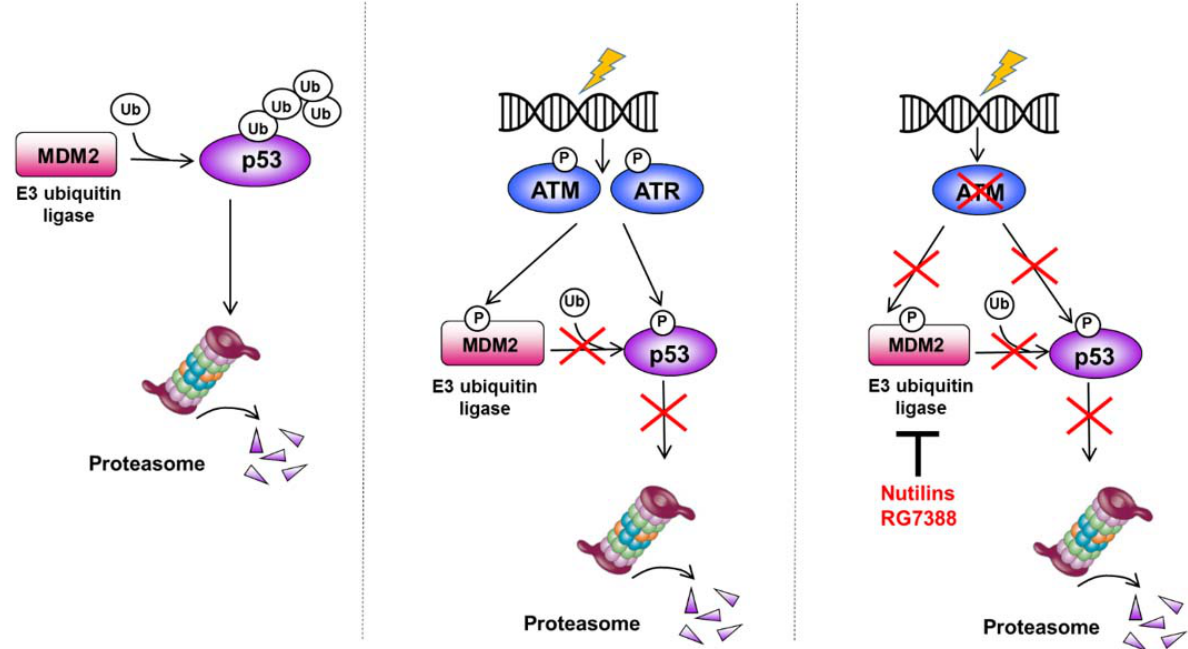
Figure 1. Targeting MDM2 to upregulate wild-type p53. Under baseline conditions, the E3 ubiquitin ligase MDM2 targets p53 for proteasome degradation by ubiquitination ( left panel ). Following induction of DNA double- or single-strand breaks, ATM and ATR kinase are respectively activated, leading to phosphorylation of both MDM2 and p53, with consequent inhibition of MDM2 activity and p53 upregulation ( middle panel ). In the absence of ATM function, MDM2 continues to induce p53 degradation, despite the presence of DNA damage. This effect can be counteracted by MDM2 inhibitors such as nutlins or RG7388 ( right panel ).